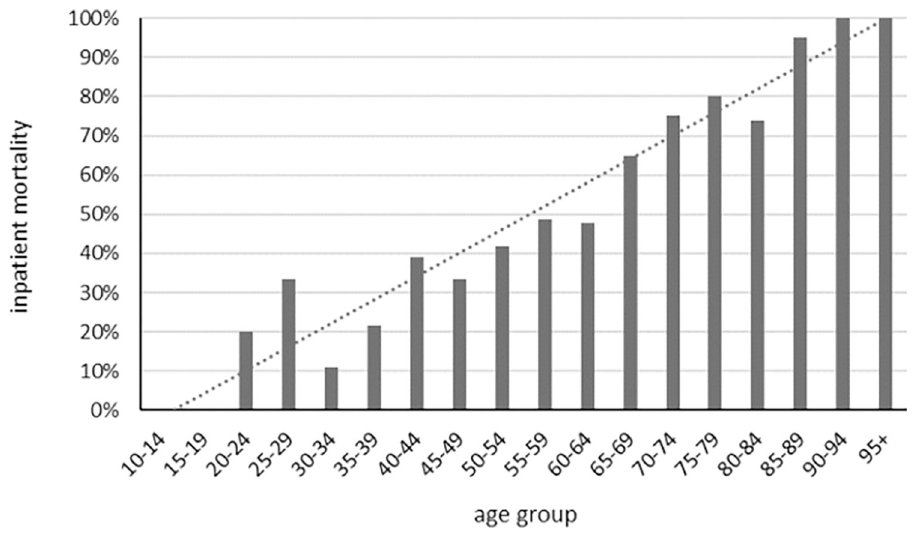
Fig 1. Linear association of inpatient mortality and age for COVID-19 patients on mechanical